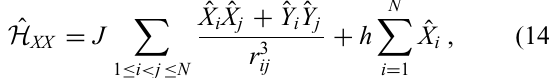
FIG. 2. Single spin flip in a XX chain with N = 64 spins (cf. experiment of Ref. [44]). (a)–(c) One- and two-body correlations at time tJ = 10, used as input to our SDP algorithm [for the sake of readability, on (c) we plot the connected correlations C ZZ Corresponding coefficients in the optimal entanglement witness. (g) On a semilogarithmic scale, noise robustness of the violation of the witness as a function of time (blue dots); and theoretical prediction for the noise robustness of the concurrence lower-bound measured in Ref. [44] (solid orange